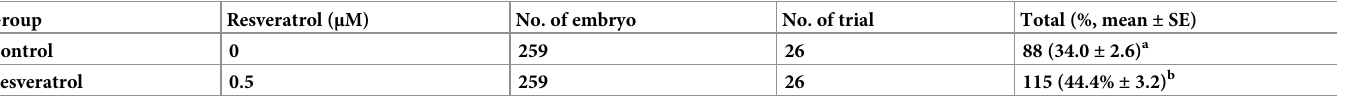
Table 2. Effect of resveratrol on the developmental ability of vitrified-warmed embryos during early developmental stage.